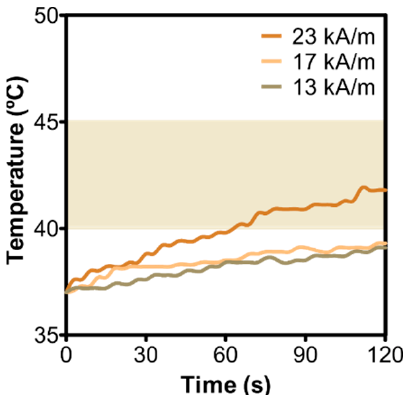
Figure 2. Time evolution of the temperature increase caused by TAT–PLGA(DOXO-BMNPs) nanoassemblies following exposure to AMF of different magnetic field strengths at a fixed frequency of 120 kHz.